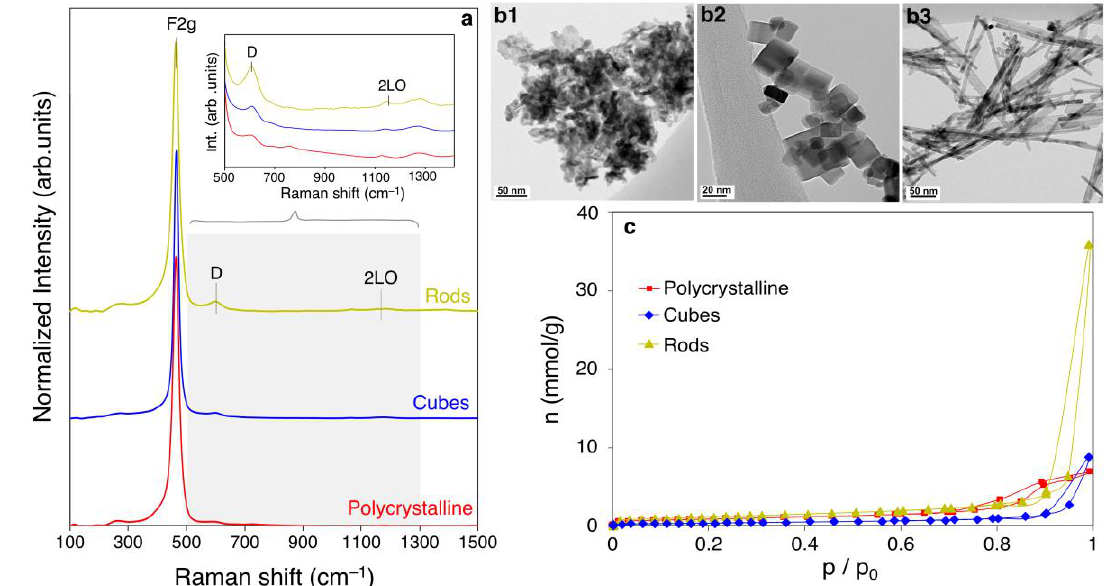
Figure 1. ( a ) Raman spectra of the prepared ceria catalysts with zoomed 500–1300 cm − 1 range inset; ( b ) TEM images of polycrystalline ceria ( b1 ), nano cubes ( b2 ) and nano rods ( b3 ); ( c ) N 2 physisorption isotherms recorded at − 196 ◦ C for the different ceria